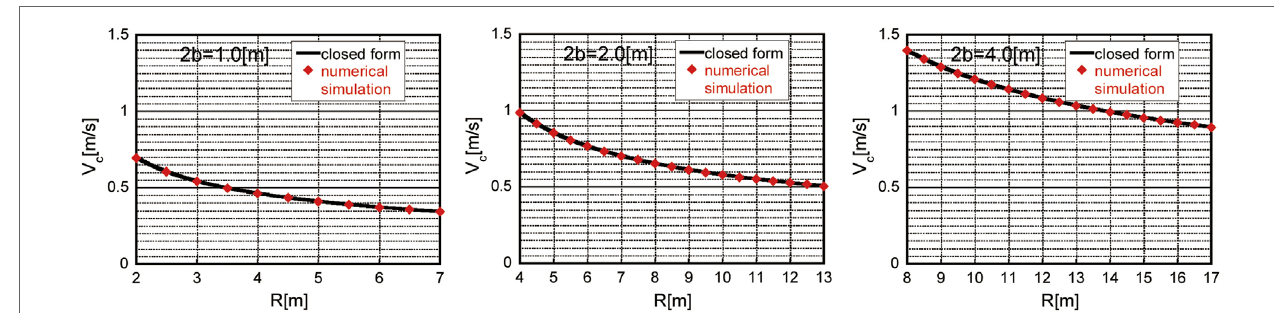
FigUre 8 | limit velocity amplitude of critical double impulse with respect to R for 2 b = 1, 2, and 4 m (closed-form expression and numerical simulation)